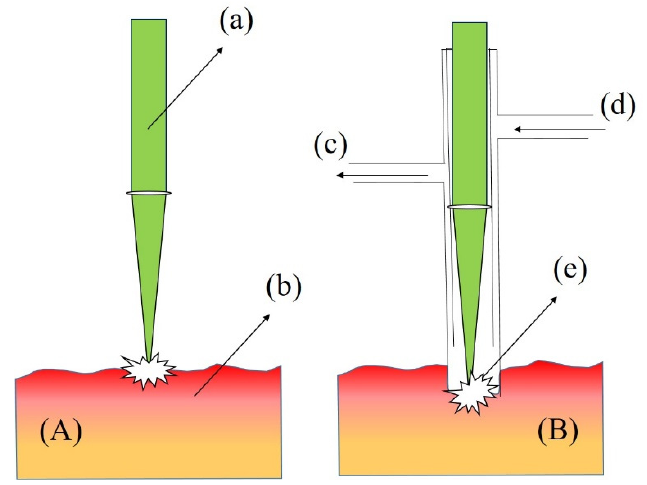
Figure 1. Basic schematic diagram of LIBS investigation of the molten metal, obtaining spectrochemical information by focusing a laser pulse ( A ) on the surface, ( B ) inside melt using a tube with the provision of purging inert gas in and out to maintain opening for the interaction. The parts of the diagram are (a) pulsed laser, (b) melting pool of metal, (c) outlet gas, (d) inlet gas, and (e) laser-induced plasma.